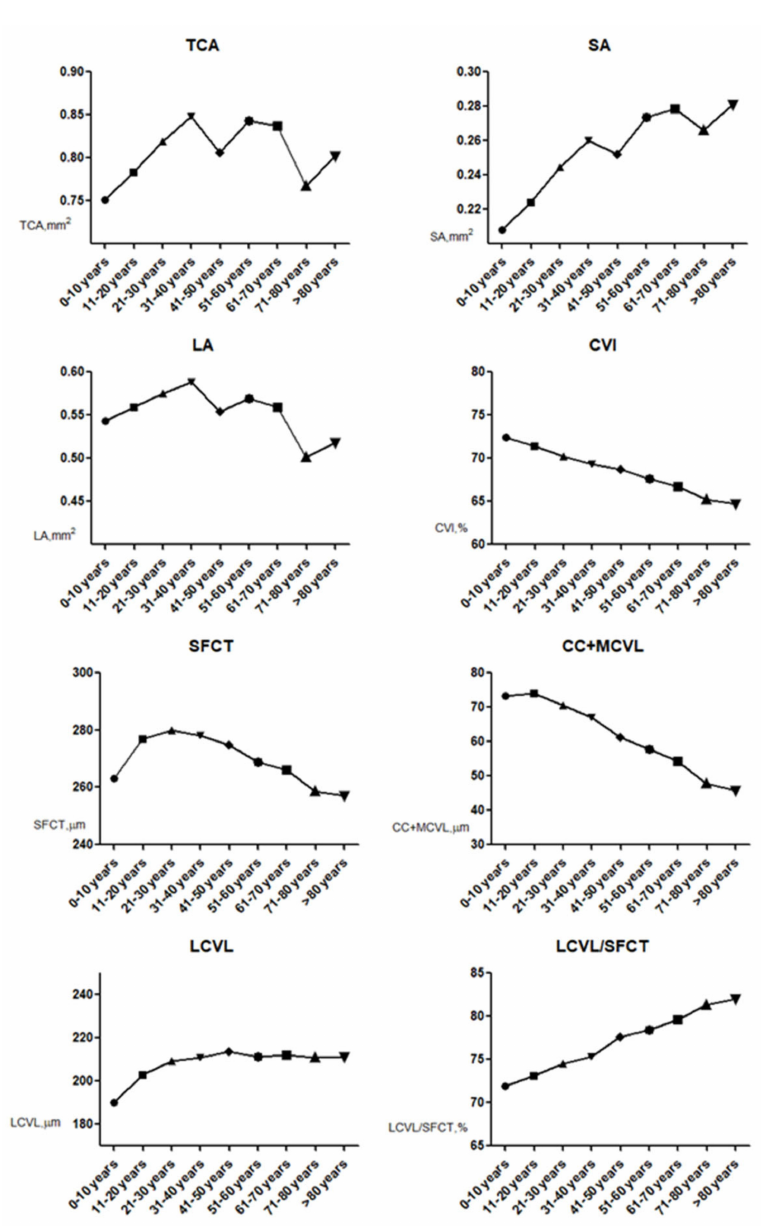
Figure 4. Age group curves for each choroidal parameter. CVI decreases gradually with age, and LCVL/SFCT increases gradually with